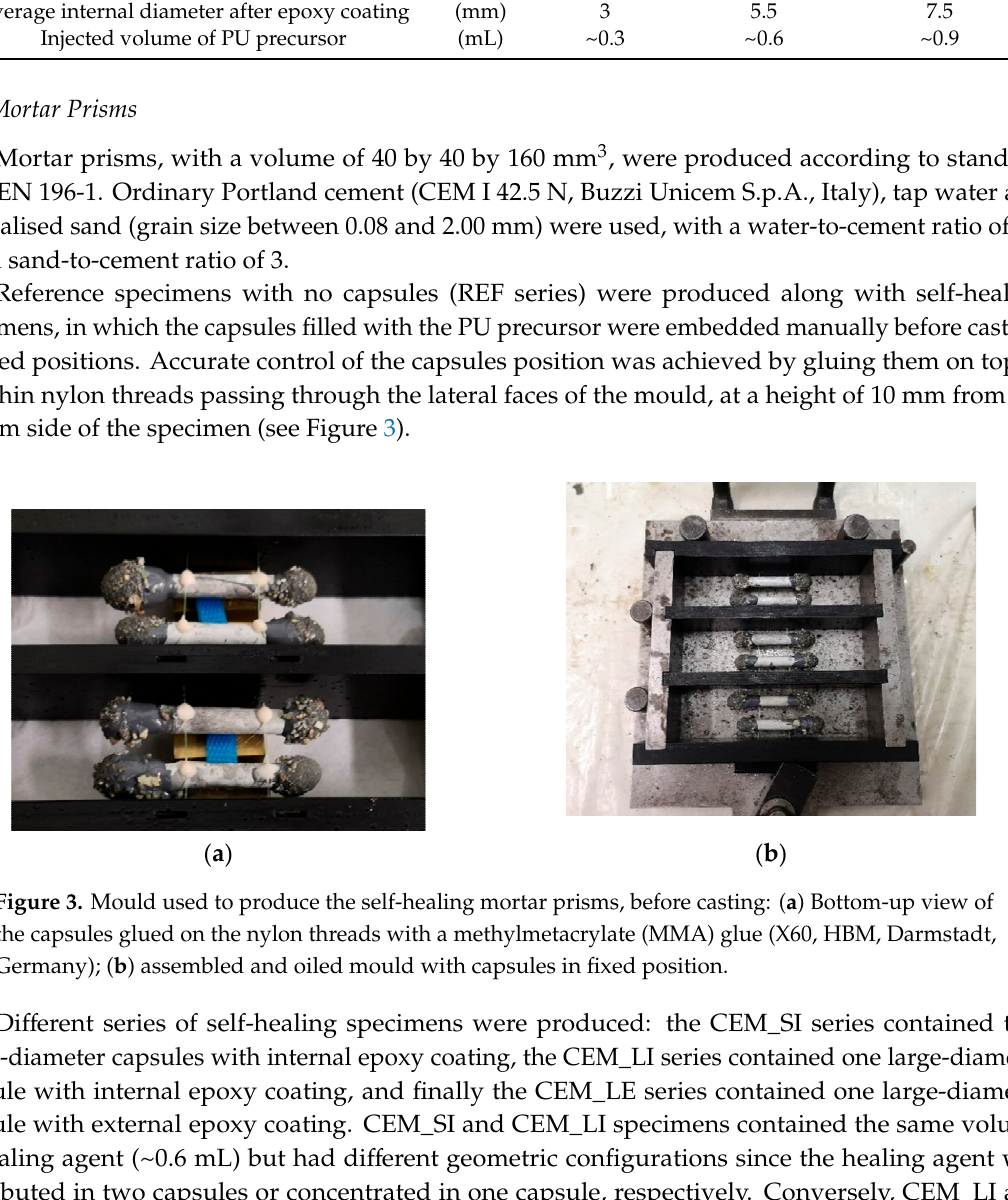
Figure 3. Mould used to produce the self-healing mortar prisms, before casting: ( a ) Bottom-up view of the capsules glued on the nylon threads with a methylmetacrylate (MMA) glue (X60, HBM, Darmstadt, Germany); ( b ) assembled and oiled mould with capsules in fixed position.